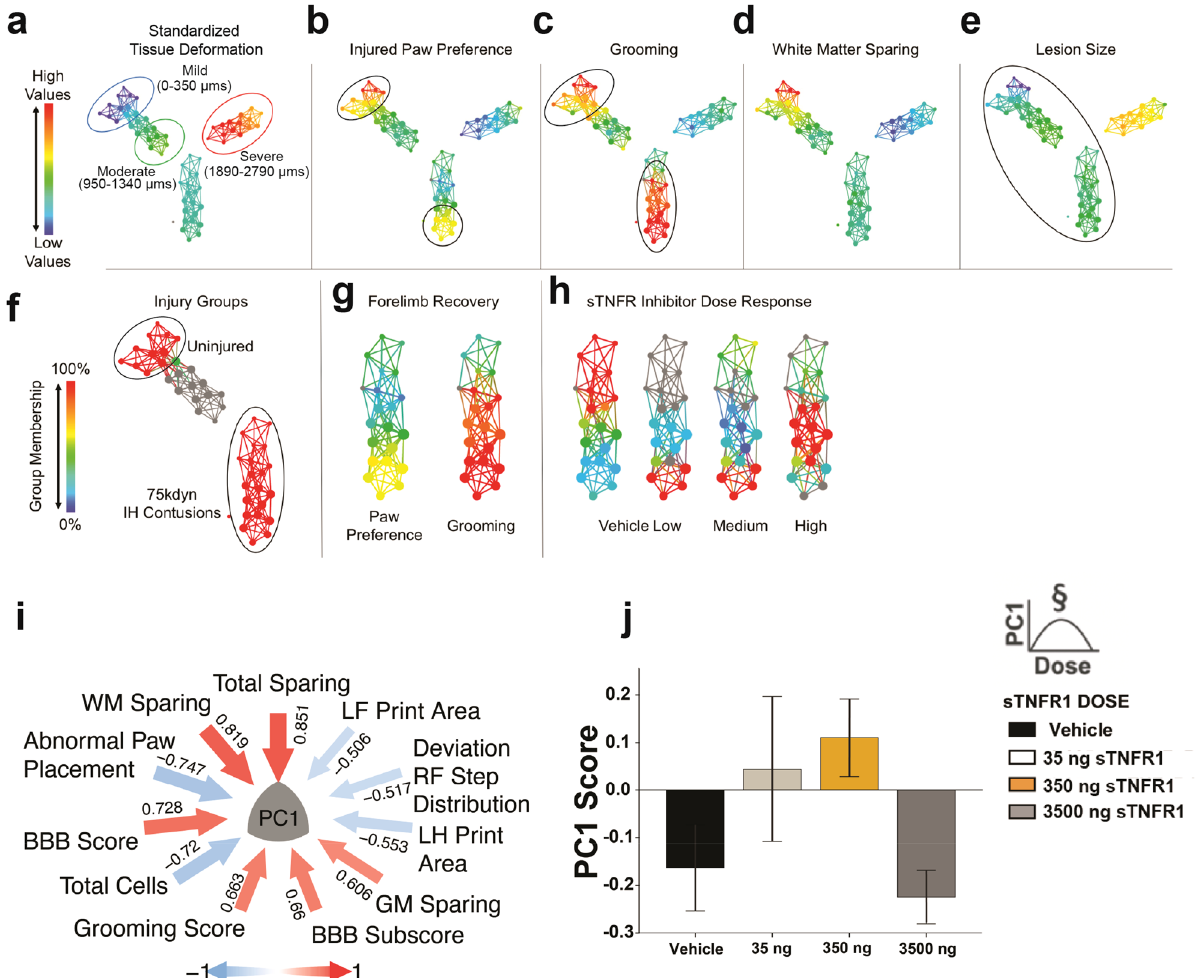
Figure 1. Topological data analysis (TDA) identifies sTNFR1 among 5 preclinical trials as effective therapy after SCI. High-content data from 5 previous unpublished preclinical SCI trials were merged and topological data analysis was run in order to extract syndrome-level information (N = 159 rats). The multidimensional array of outcome measures was mapped to a data topology, with nodes (colored circles) representing clusters of subjects that share similar multivariate patterns, and edges (lines) that represent shared similarities between nodes. TDA on all animals in preclinical drug trials revealed a distinct separation of subjects based on injury severity (tissue deformation, in microns) ( a ). Filtering the topology to show the relative values of different measures across the entire subject set reveals how those with moderate injuries have a distinct, non-uniform pattern of recovery ( b – e ). A robust recovery of forelimb function (black circles, ( b , c ) not dependent on tissue pathology ( d – e ) was observed. Exploration of nodes of interest (black circle, e ) revealed they were given the same 75 kdyne IH contusion injury ( f ), and that the robust forelimb recovery ( g ) was the result of a dose response to sTNFR1 treatment ( h ). Heat maps: high-low for values ( a – e , g ), 100–0% for group membership( f , h ). Principal components analysis on all hemicontusion data revealed a first principal component (PC1) that explained 27.1% of the total variance in the dataset ( i ). Hypothesis testing for an effect of sTNFR1 on PC1 revealed a significant dose response effect (polynomial contrast), indicating that sTNFR1 treatment has a multivariate effect that is detectable across the syndromic SCI space ( j ). Error bars represent standard error of the mean, *p < 0.05. Plots ( a – h ) generated using Ayasdi software (Ayasdi, Inc v 2.0, www.ayasd i.com), plot ( i ) generated using the syndRomics package in R 48,49 clear relationship between spared tissue and neurological function within the sTNFR1 cohort, perhaps implicat- ing more subtle aspects of recovery (e.g. ‘plasticity’). Whatever the mechanisms underlying this positive result, we recognized that the effects of immediate application needed to be extended to later time points if these results were to be relevant to developing therapies for translation. Thorough exploration of time and dose–response variations with studies of long-term outcome is time and effort intensive, so we looked for early biological indices, or surrogate measures, that might predict long-term outcome. We hypothesized that early neuroinflammation (NI) would be correlated with neurological outcomes, and early markers of NI could be used to test for acute effects of sTNFR1 that might translate into long term neurological improvements. Thus, we examined the effects of delayed (90 min post-injury) sTNFR1 on the early production of TNFα and related inflammatory cytokines